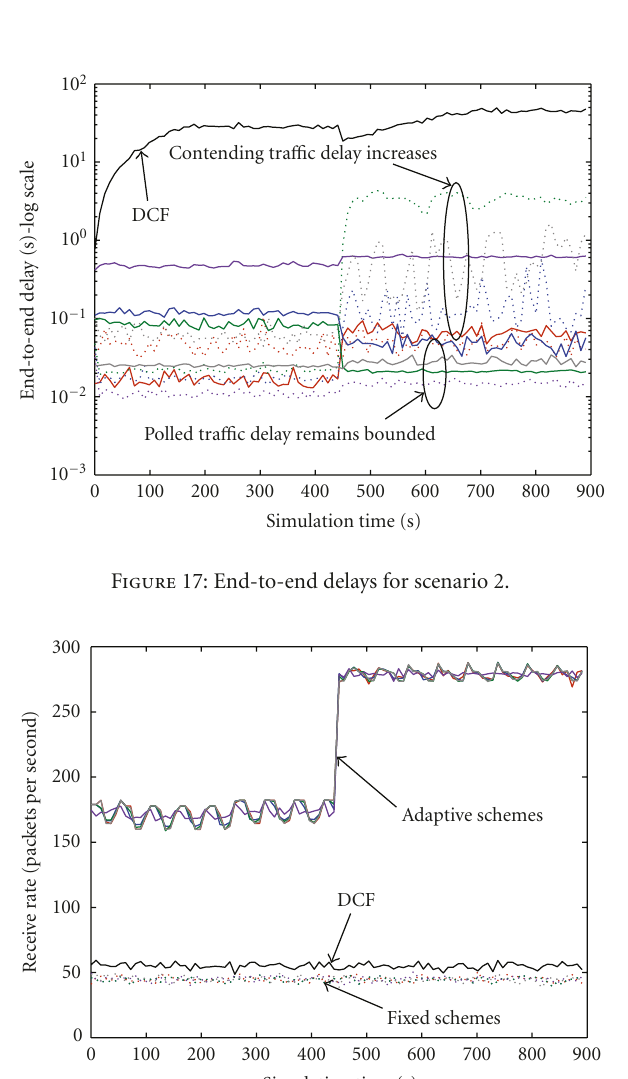
Figure 16: Receive rates for scenario 1.